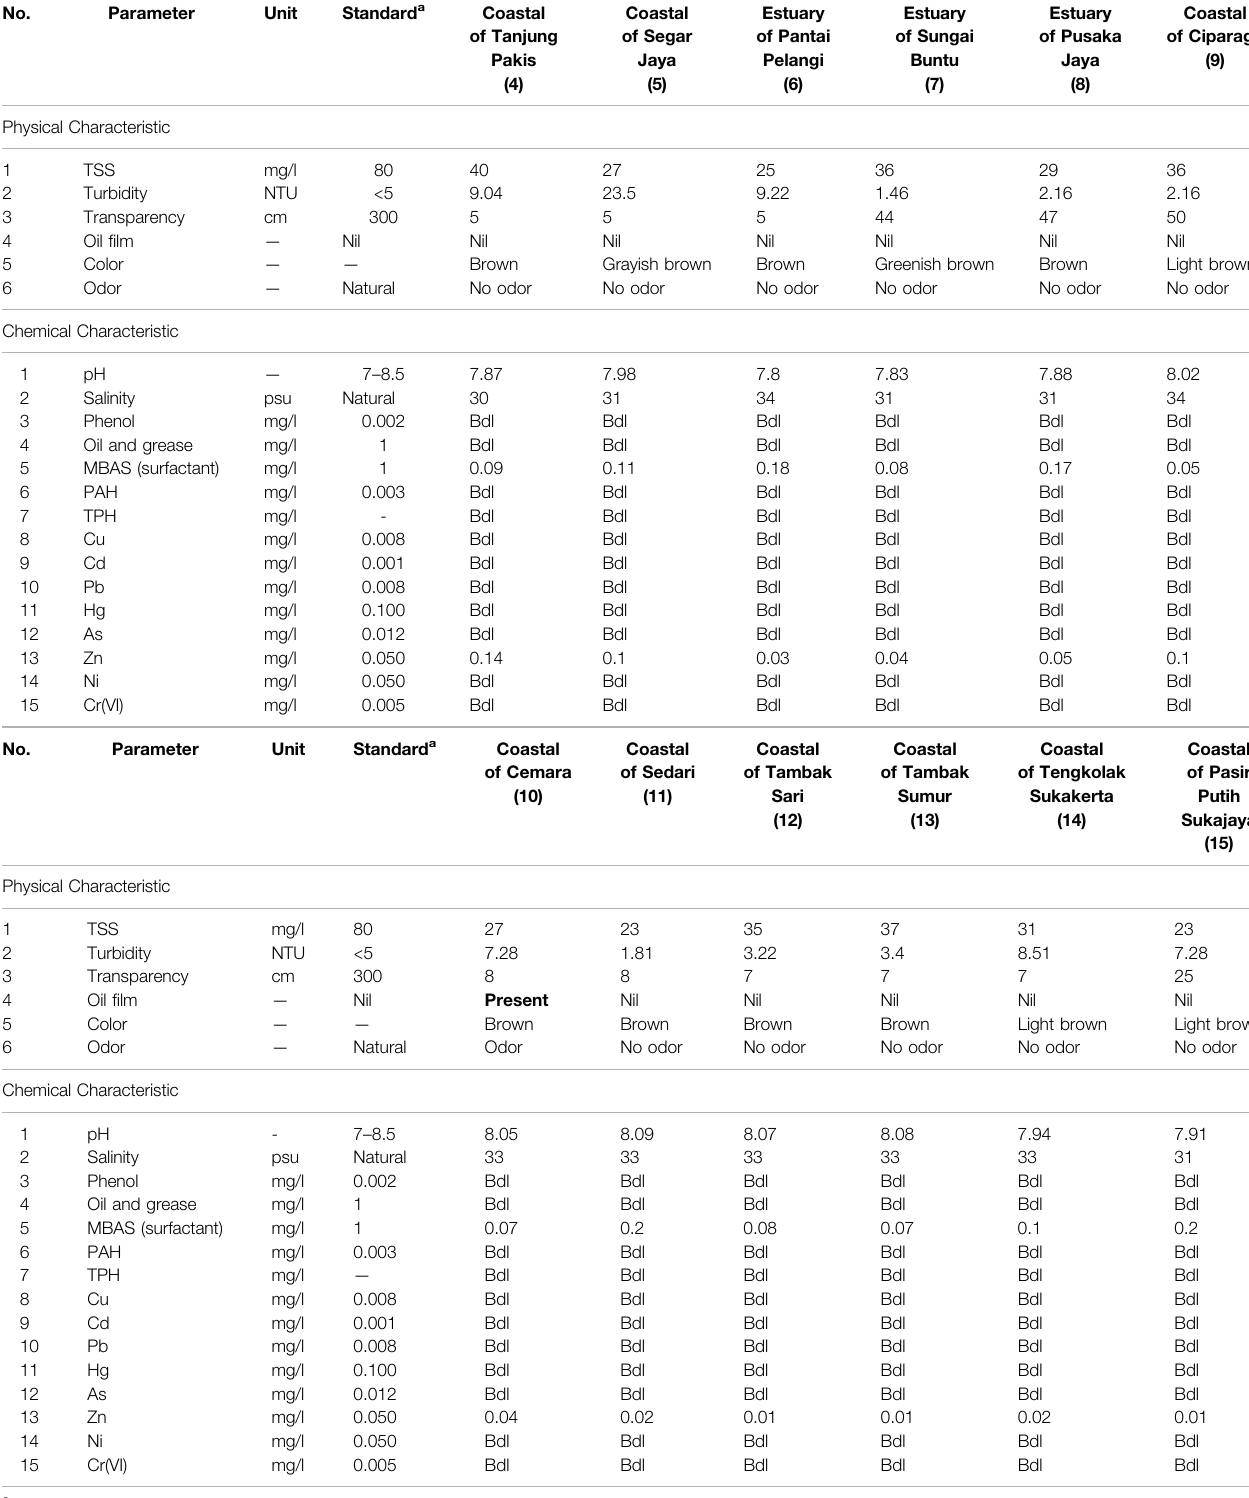
TABLE 2 | Coastal water quality of Karawang (ERC IPB